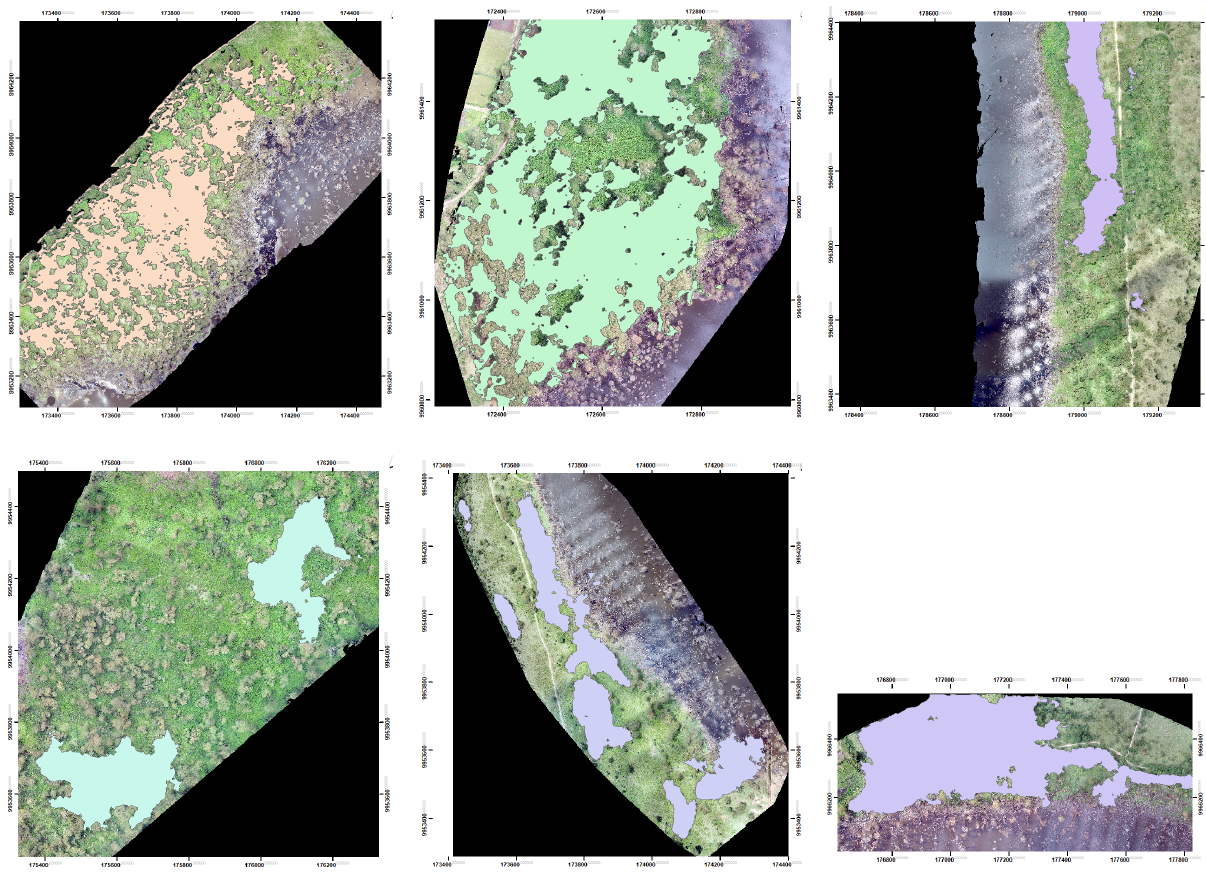
Figure 2. The six flight missions captured from different sites around the Lake using DJI Phantom 4, SDK Drone. The overlay vector polygons were derived from QGIS-based forest detection plugin, Mapflow.ai representing the detected trees on each imagery. water loss. Four seasonal rivers feed the lake, i.e.